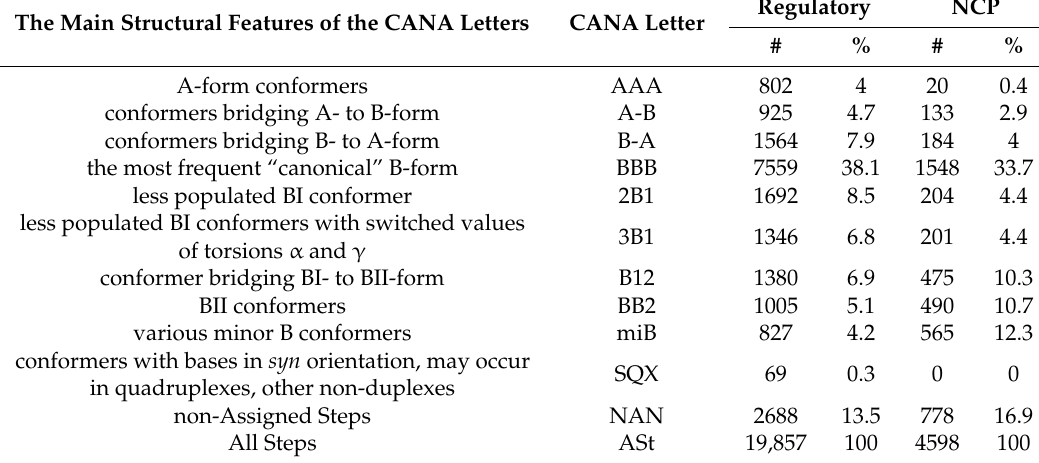
Table 1. Numbers of letters of the dinucleotide DNA alphabet CANA observed in the analyzed complexes of regulatory proteins and in nucleosome core particle (NCP). The incidences of the alphabet letter SQX were not analyzed, no Z-DNA letter ZZZ was